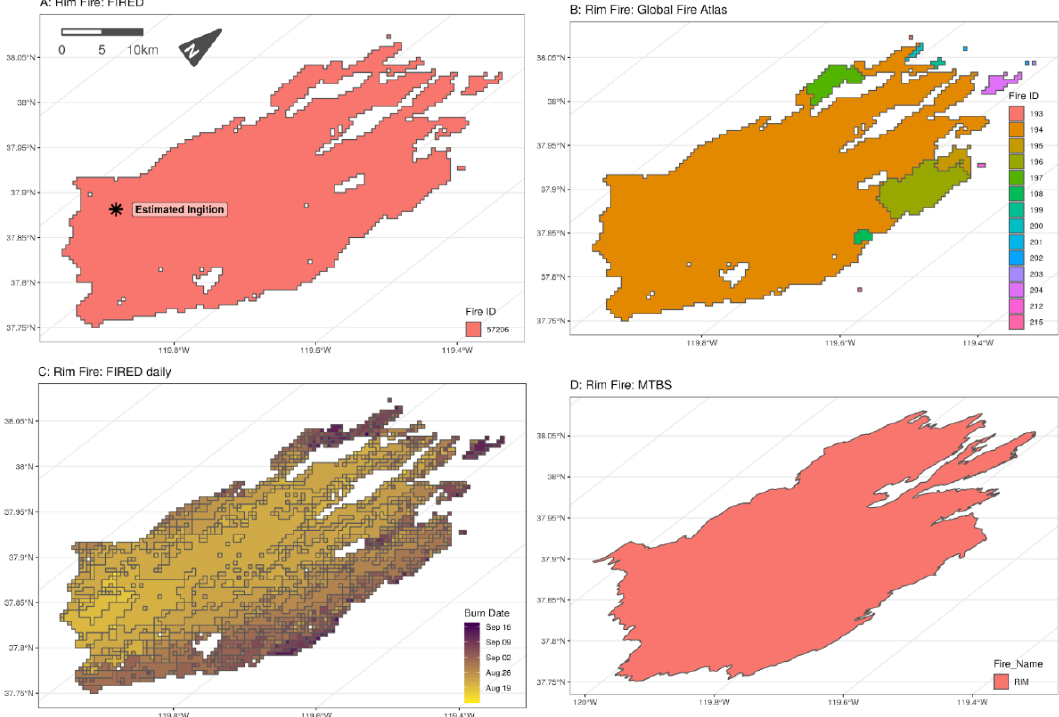
Figure 4. The 2013 Rim Fire, which lasted over a month and was more than 100,000 ha in total size according to incident reports, as delineated by the ( A ) FIRED event product; ( B ) global fire atlas; ( C ) FIRED daily event product; and ( D ) MTBS. The optimized spatial-temporal criteria we used allowed us to correctly classify it as a single event, while the global fire atlas has segmented the Rim Fire into 14 separate events. The FIRED ignition point is estimated as the average location of all pixels occurring on the first day of the